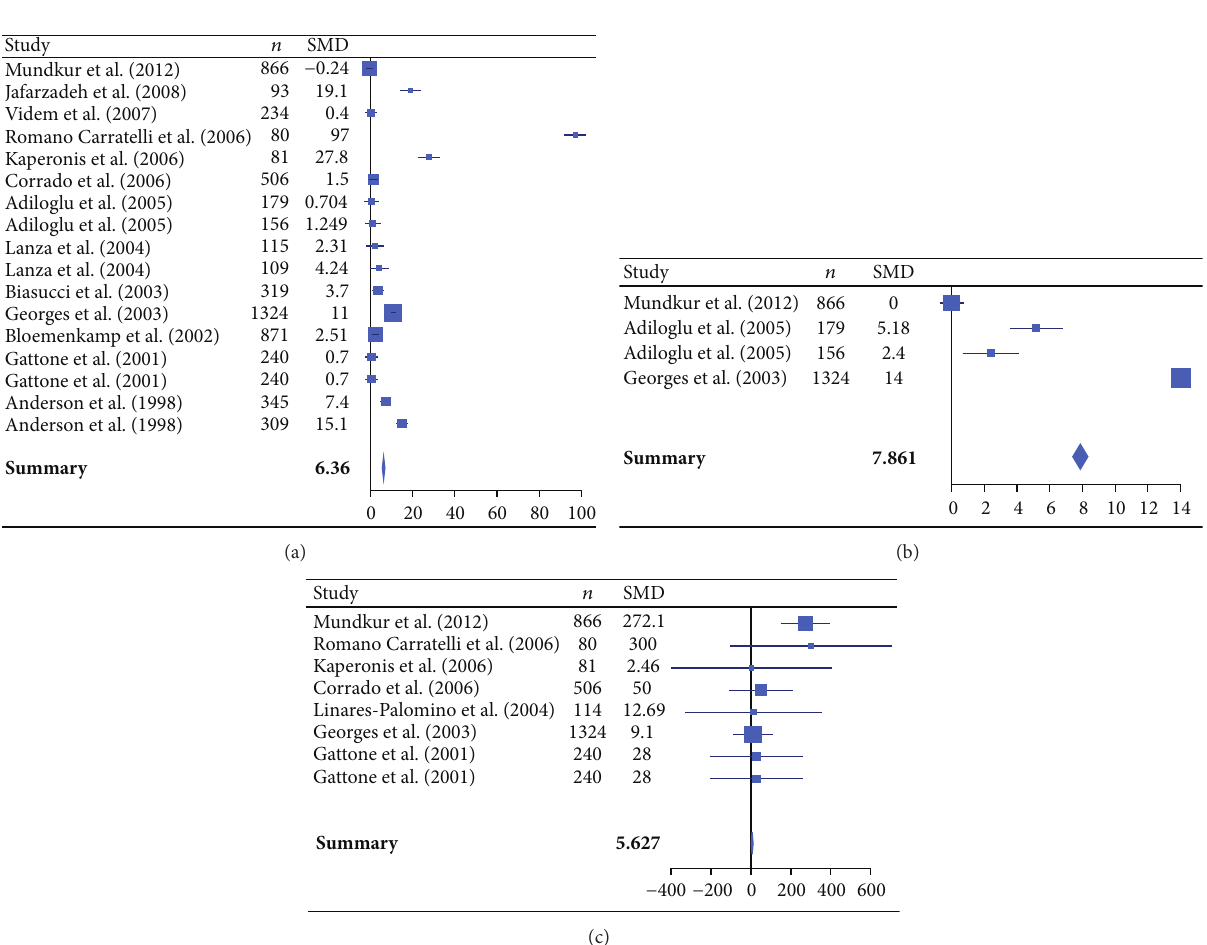
Figure 1: Forest plot of standardized mean differences (SMDs) of individual studies and pooled SMDs for hsCRP (a), IL-6 (b), and fibrinogen (c) in patients with atherosclerotic cardiovascular diseases and healthy